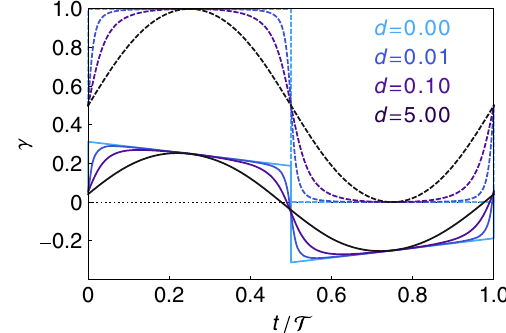
t; d Þ defined in FIG. 4. Plots of the temperature protocol γ q ð Eq. (80) (dashed lines) and the corresponding optimal protocol γ (cid:3) t; η ; d Þ for the trap strength (solid lines) obtained from w ð Eq. (74) for four different values of the parameter d as functions of t= T [53]. For all plots, we have set 2 μκ 0 T ¼ 1 and ¯ η ¼ 1 = 2 . t Þ has been rescaled by the Additionally, the optimal protocol γ (cid:3) w ð = κ dimensionless factor κ 0 η C